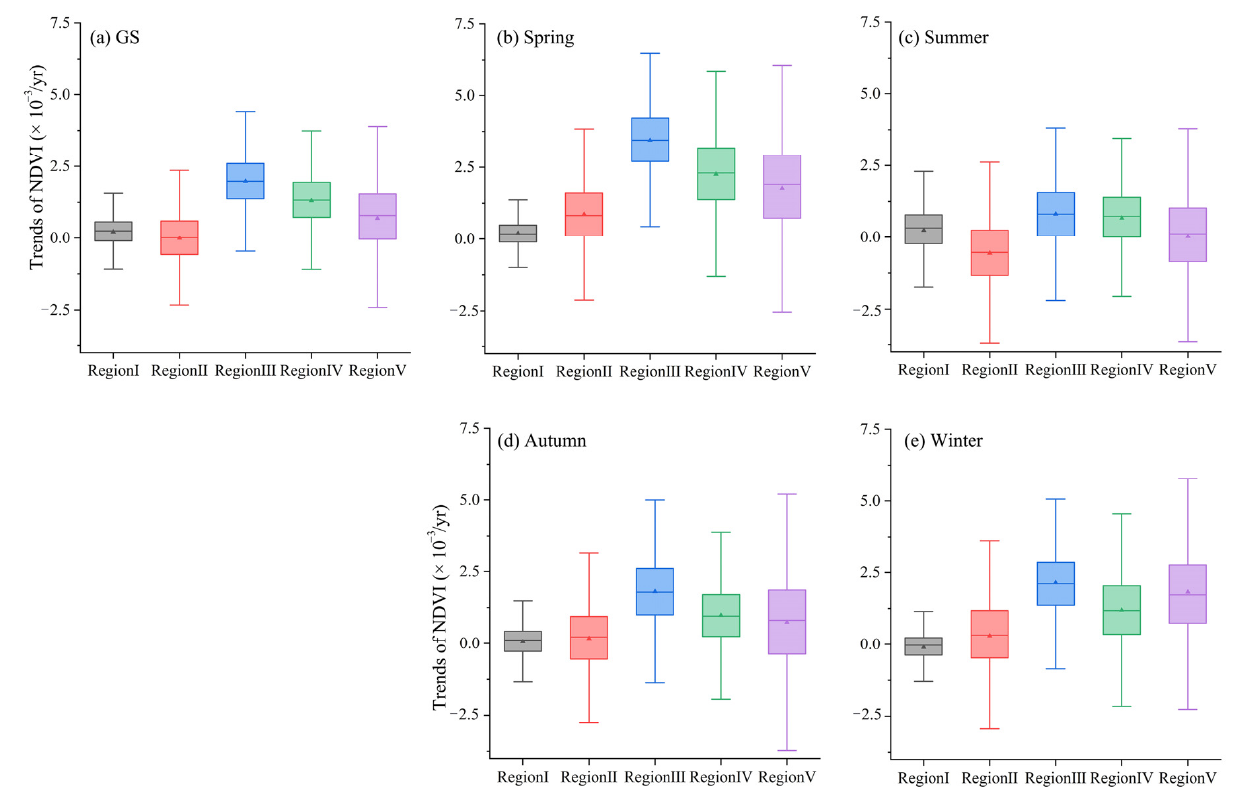
Figure 9. Boxplots for the GS and seasonal NDVI trends in subregions: ( a ) GS, ( b ) spring, ( c ) summer, ( d ) autumn, and ( e ) winter.